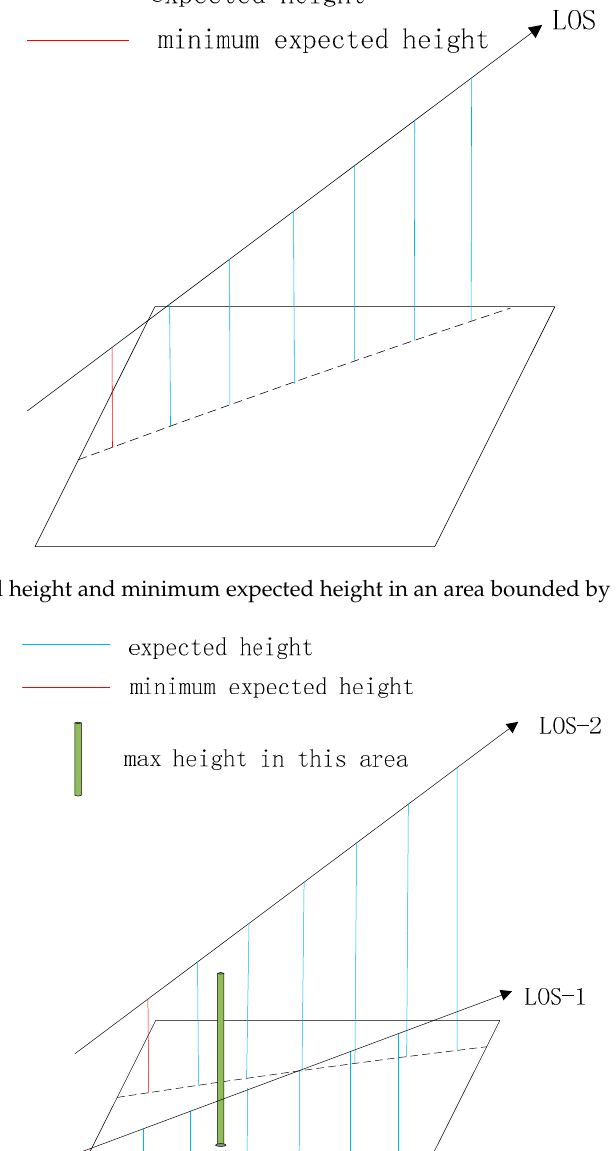
Figure 10. Regional maximum height and minimum expected height. LOS-1 and LOS-2 represent the LOS of different observation points, and they have different minimum expected heights in the same region. When LOS detects an area bounded by the parallelogram, it calculates the minimum expected height first, and then compares it with the maximum value in the area. If the minimum expected height is smaller than the regional maximum, it can go directly to the next area.